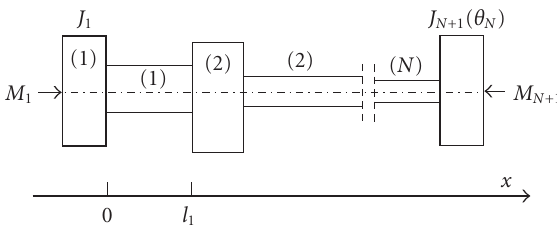
Figure 2.1. Discrete-continuous multimass torsional